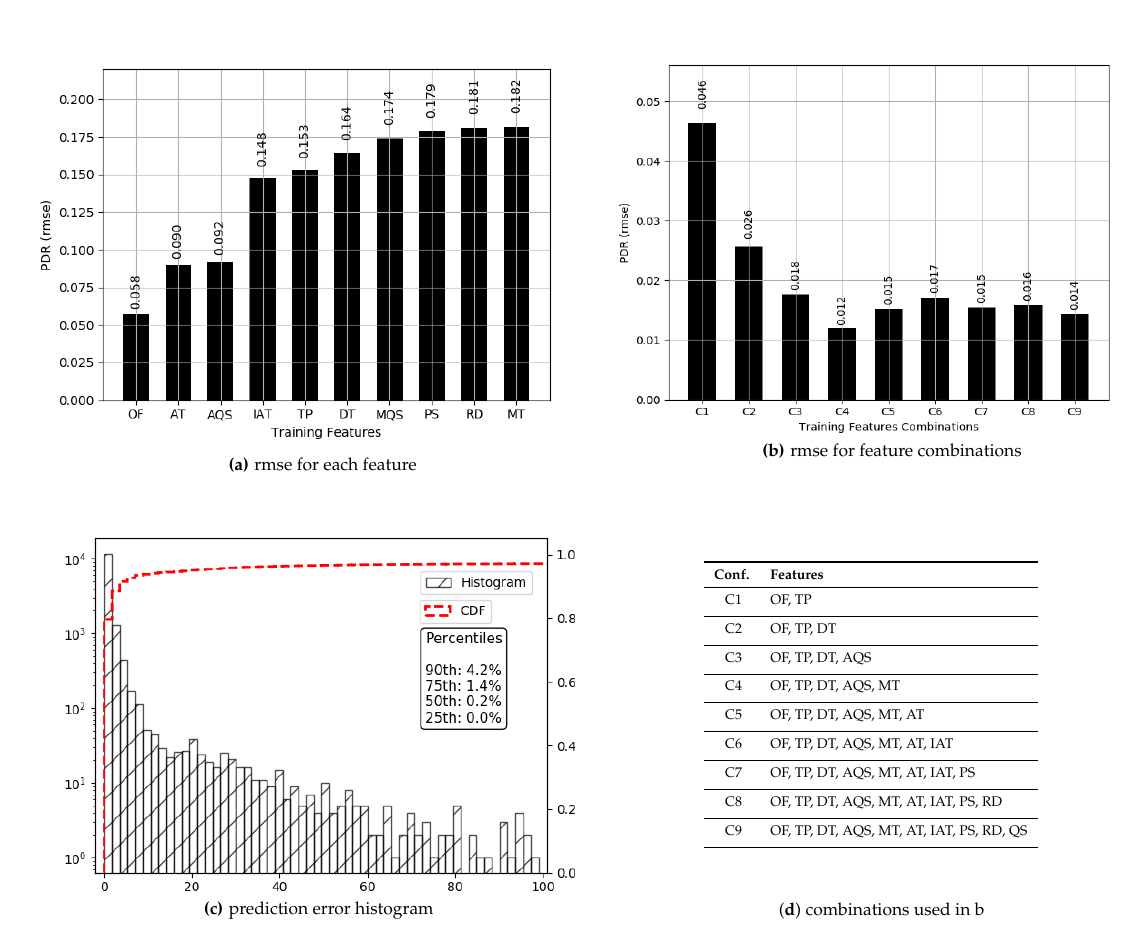
Figure 6. Prediction results for PDR